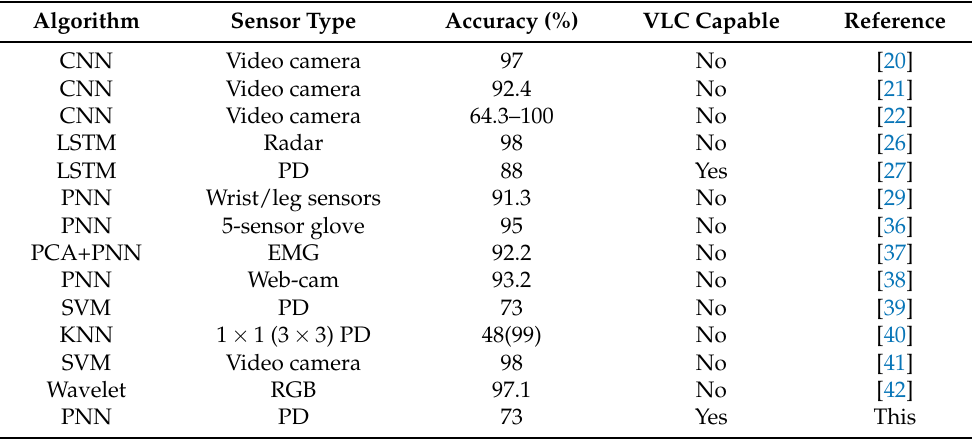
Table 1. Summary of recent gesture recognition systems using machine